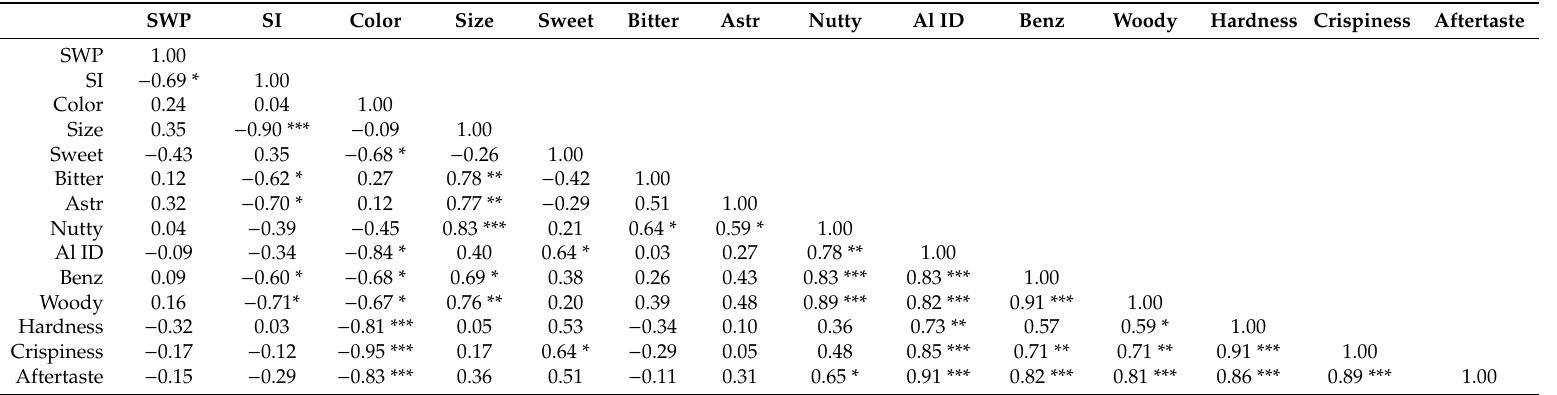
Table 5. Pearson’s correlation coe ffi cients (R) among stem water potential and stress integral with sensory analysis